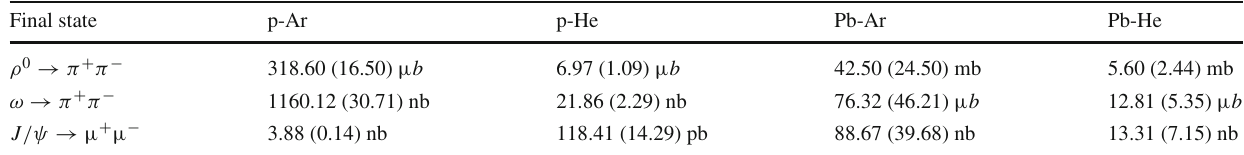
Table 1 Total cross sections for the exclusive ρ , ω and J /(cid:4) photoproduction in fixed-target collisions at the LHC considering pA ( PbA ) collisions √ s = 110 ( 69 ) at